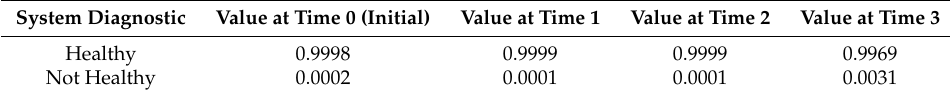
Table 7. Progression of system diagnostics following the example accident